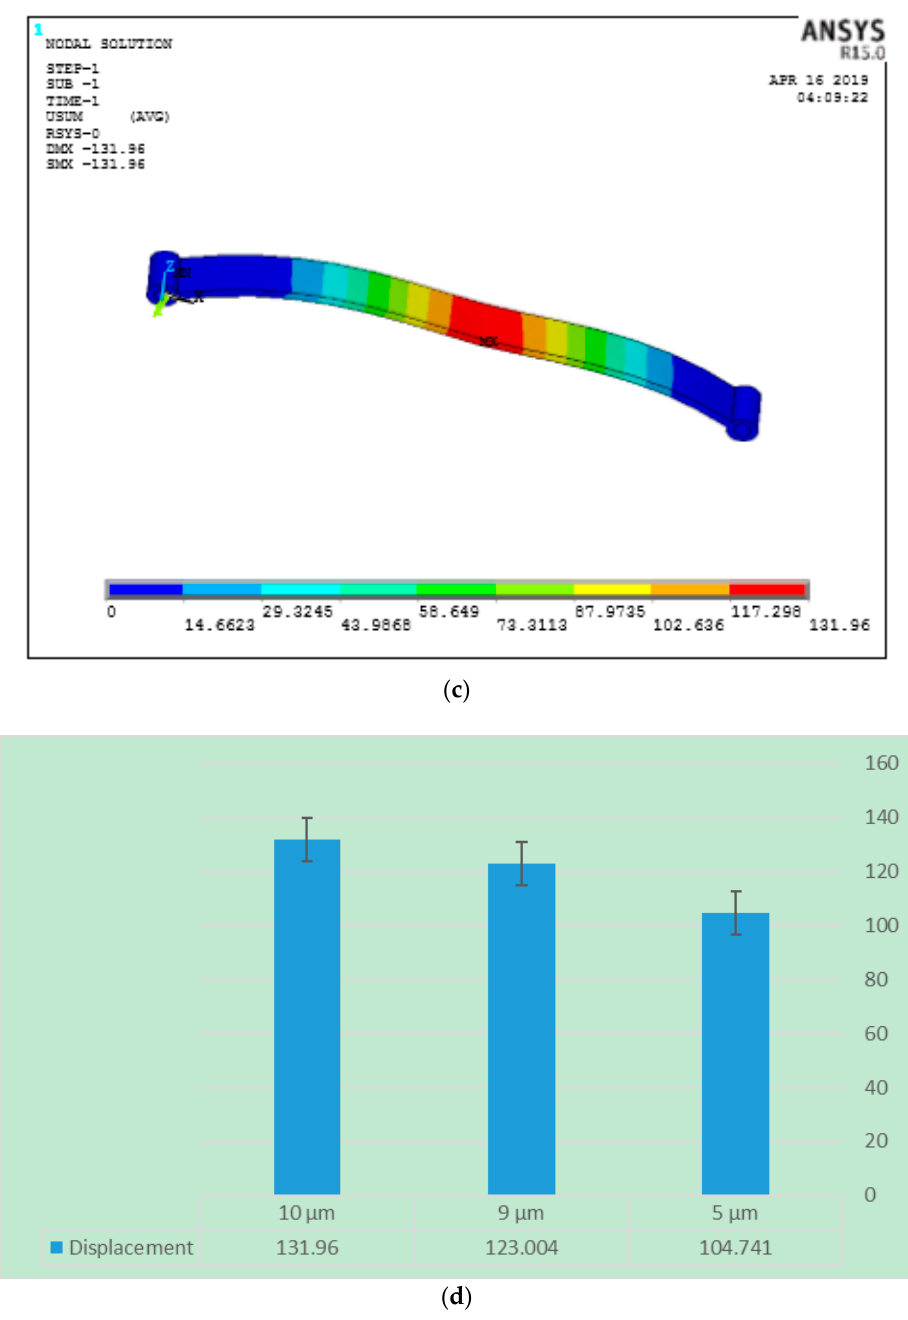
Figure 18. Deflections at different fiber diameters ( a ) 10 µm, ( b ) 9 µm, ( c ) 5 µm, ( d ) comparison of deflections with different fiber diameters.